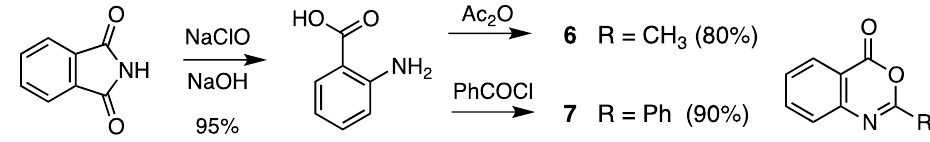
Scheme 1. Reaction scheme for the synthesis of the benzoxazine-4-one-derivatives.